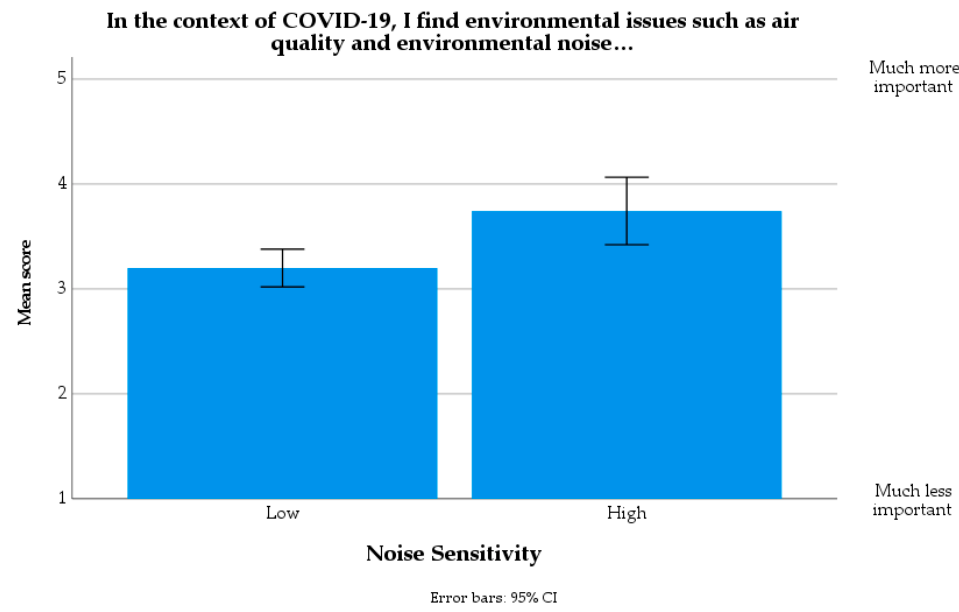
Figure 10. Mean scores for the item “In the context of COVID-19, I find environmental issues such as air quality and environmental noise…” (1–5; Much less important–Much more important), as a function of Noise sensitivity.